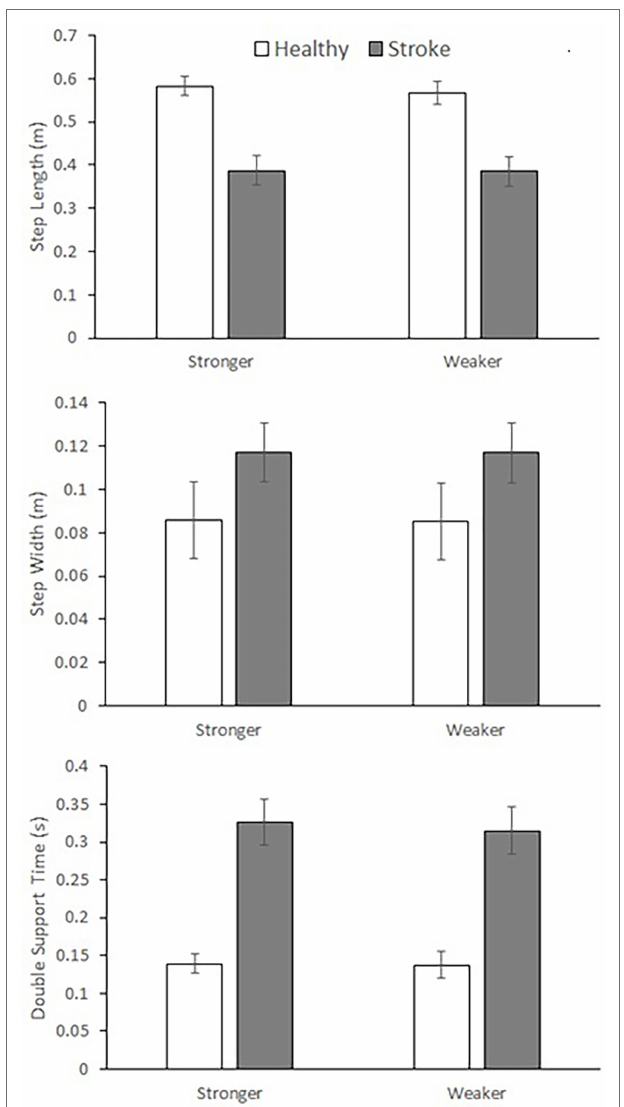
FIGURE 3 | Spatio-temporal gait parameters (mean ± SD). (top) step length = group effects for mean and SD, (middle) step width = group effects for mean and SD, (bottom) double support time = group effects for mean and SD. Stronger vs. Weaker limb classification: healthy = dominant vs. non-dominant, Stroke = unaffected vs. affected.